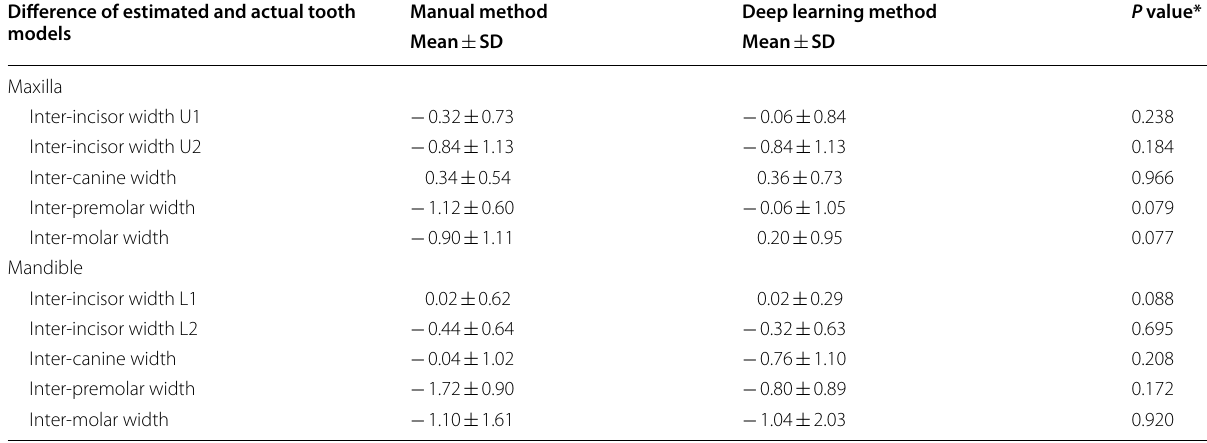
SD, Standarddeviation *The results of paired t test. U1, maxillary central incisors; U2, maxillary lateral incisors; L1, mandibular central incisors; L2, mandibular lateral